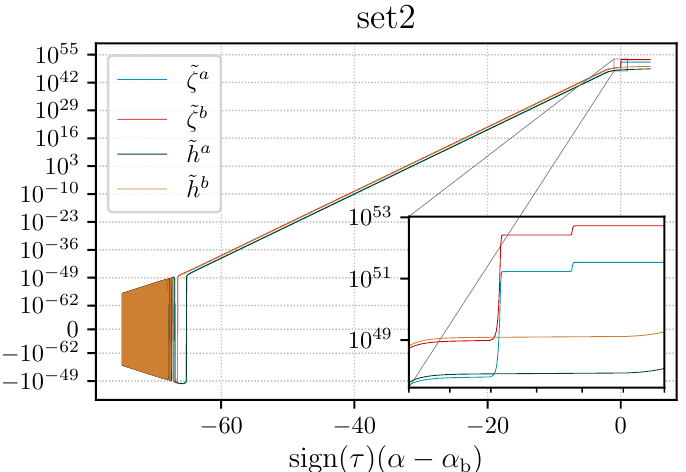
Figure 9. Evolution of scalar and tensor perturbations in the background of case B. Scalar and tensor perturbations grow almost at the same rate during classical contraction, but at the quantum bounce, the scalar perturbations are enormously enhanced over the tensor perturbations due to the quantum effects (shown in the detail of the figure). After the bounce, the perturbations get frozen. The final amplitudes of both perturbations are compatible with observations. The indices a and b refer to the real and imaginary parts of the perturbation